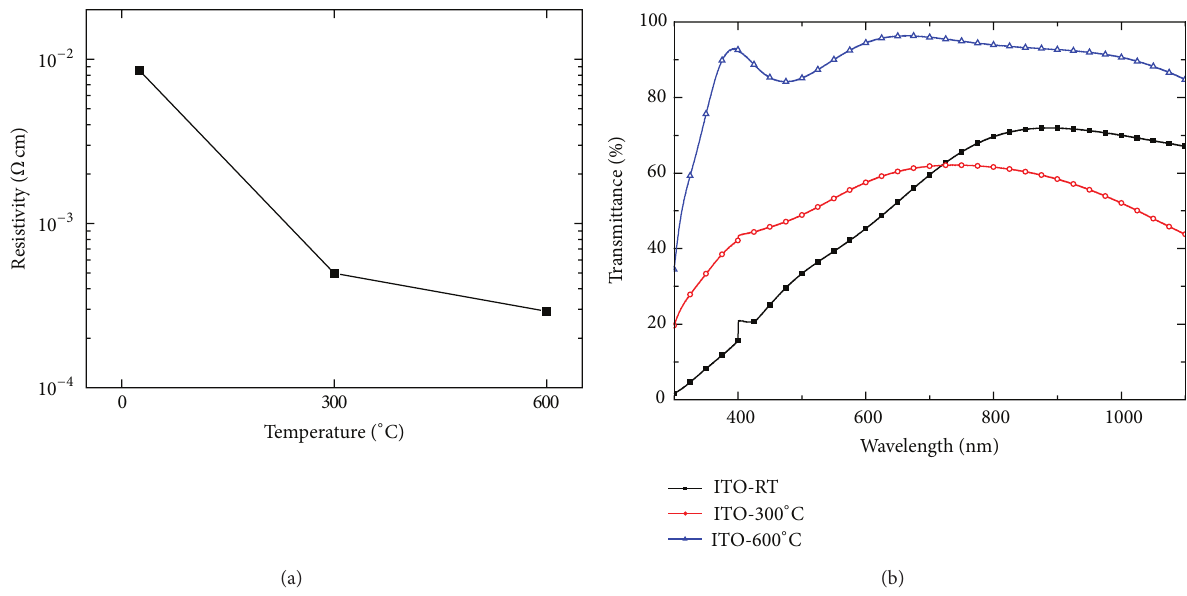
Figure 14: (a) Resistivity and (b) optical transmittance values of ITO-RT, ITO-300 ∘ C, and ITO-600 ∘ C samples [4].